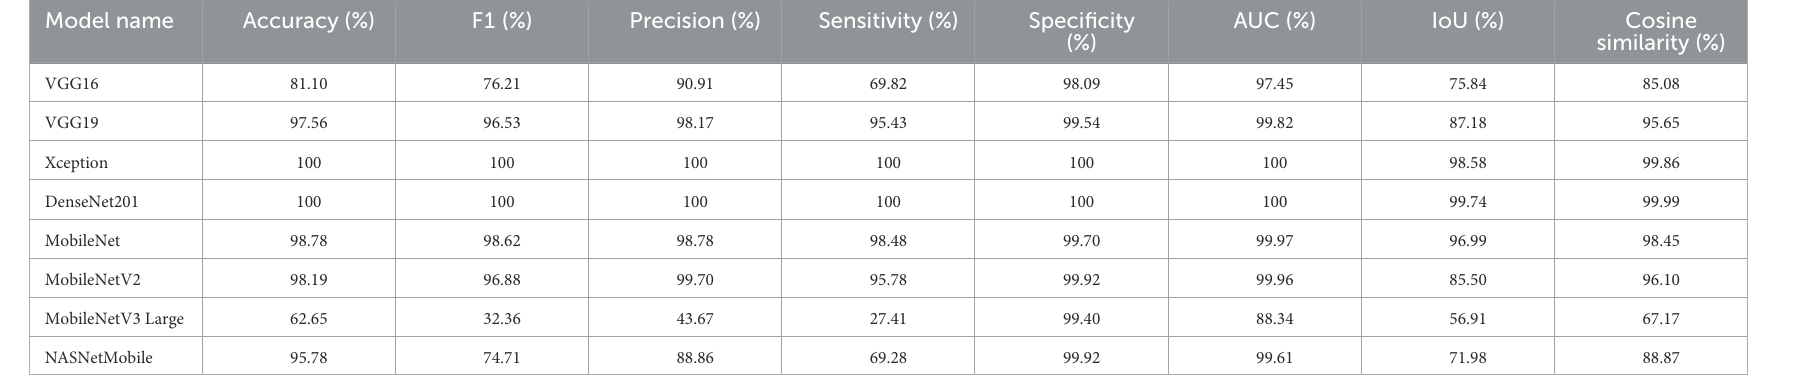
TABLE 15 The Five-classes dataset experiments with the maxmimized